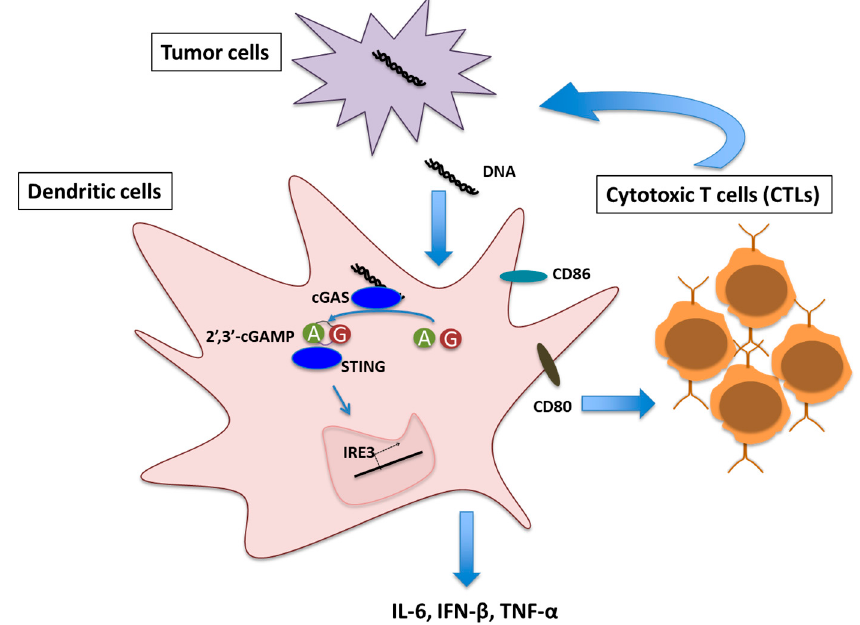
Figure 1. Schematic representation of Cyclic GMP-AMP synthase (cGAS)/Stimulator of interferon genes(STING) signaling mediated T cell priming in tumor microenvironment. A and G denotes Adenosine monophosphate (AMP) and Guanosine monophosphate (GMP) respectively.